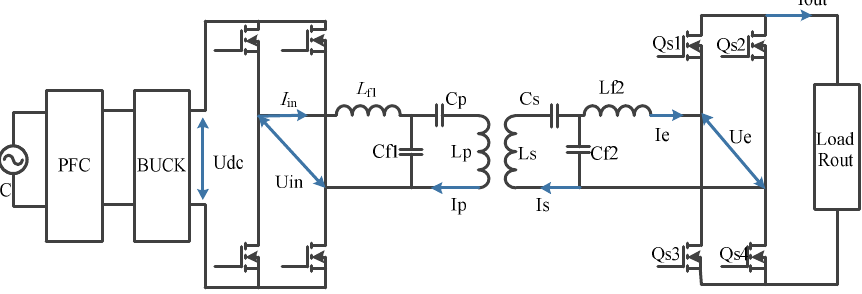
Figure 2. WPT compensation network for electric vehicles in SAE J2954 .